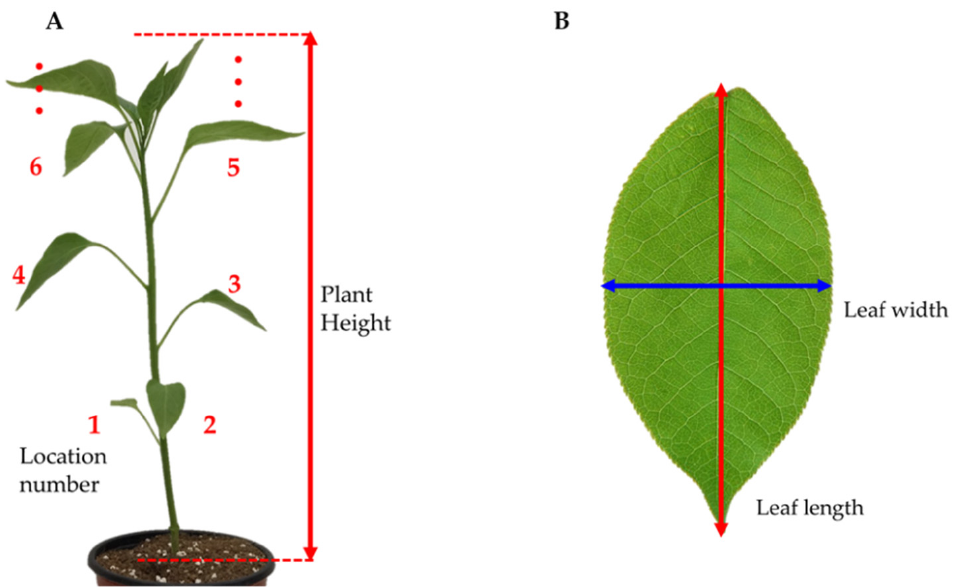
Figure 2. Measurement method for the crop and leaves: ( A ) plant, ( B ) leaf. The size of each 3D image was analyzed using MeshLab software [34]. The artificially segmented image was measured using MeshLab measurement tool and corrected values were compared with actual measured values. Kinect software development kit, C++, OpenCV library, GMLC++ camera calibration toolbox, and 3D restoration commercial software were used for 3D reconstruction. In addition, Python and MATLAB were used for the segmentation and measurement parts related to automatic analysis of 3D